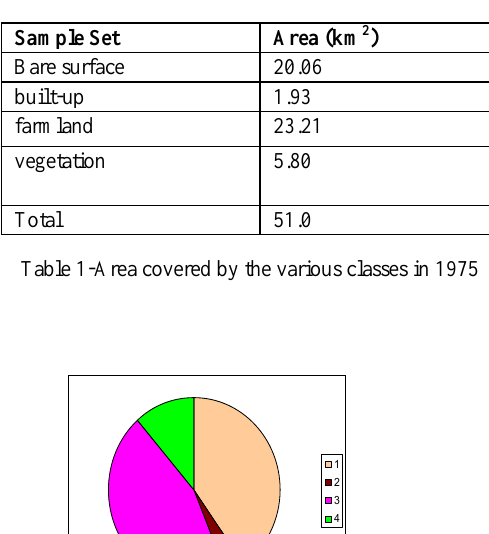
Figure 2b-Land use/Land cover map of study area derived from Landsat MSS imagery for 1975